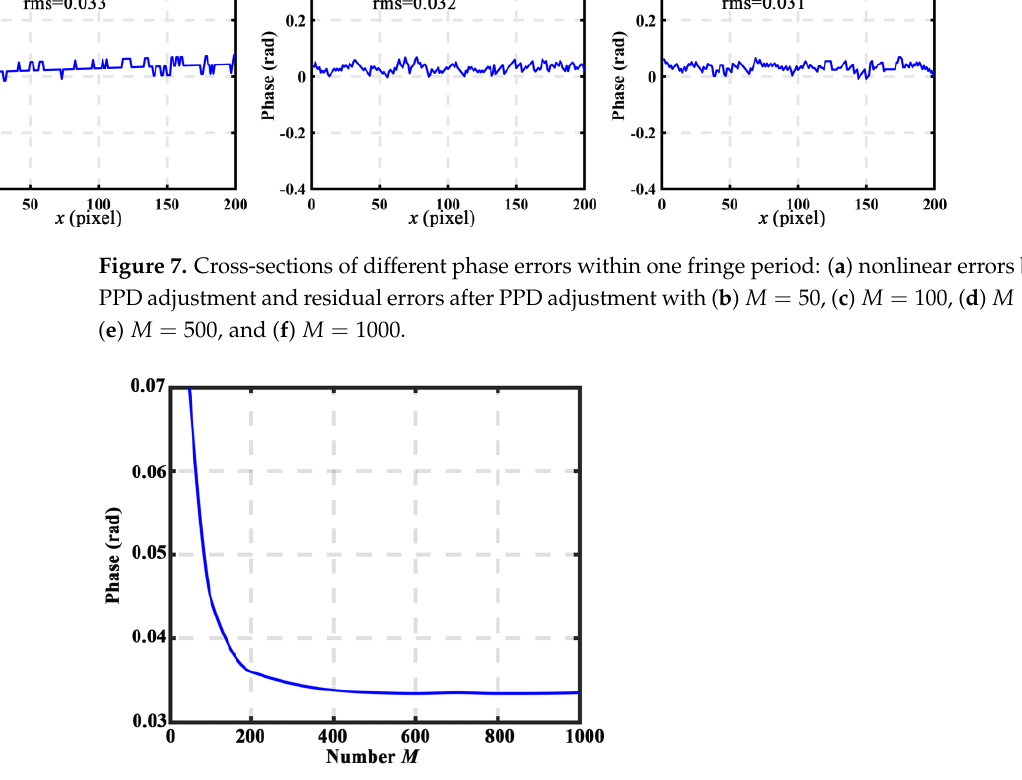
Figure 8. RMS residual errors under different M values.